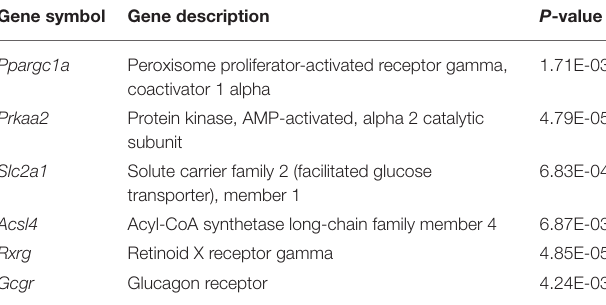
TABLE 4 | 6 DEGs associated with glycometabolism signaling pathway in